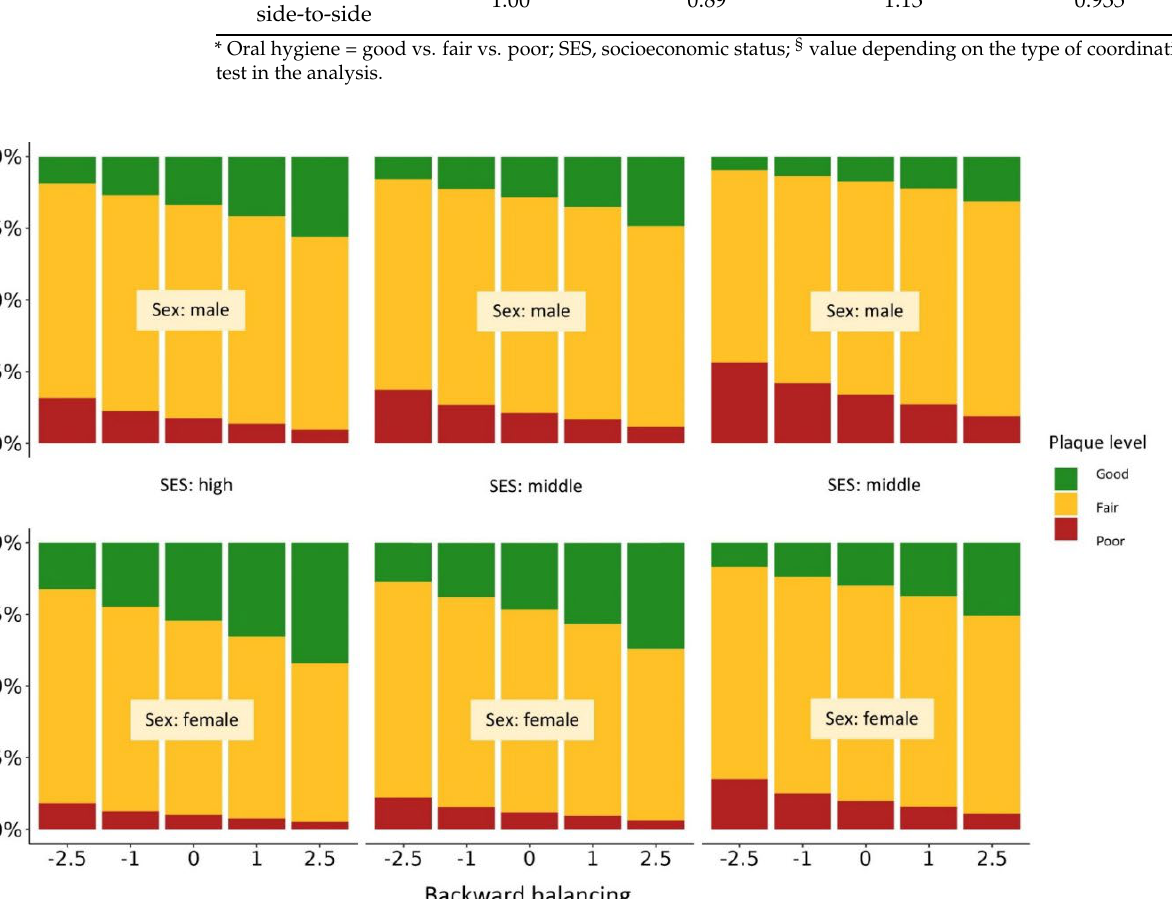
Figure 4. Proportional odds model of oral hygiene and the coordination one-leg-stand test.